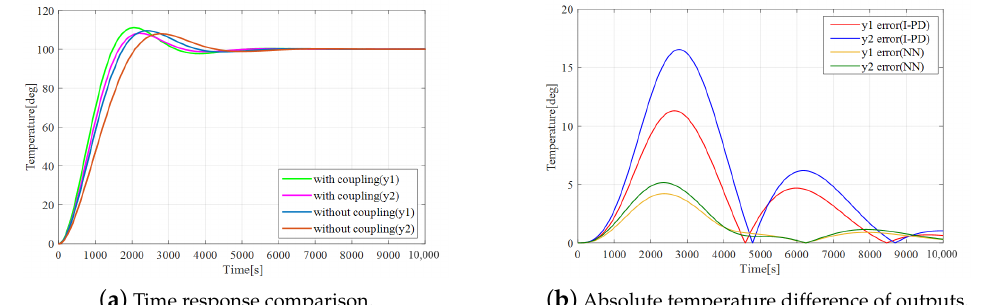
Figure 10. Analysis of coupling effects in the control system. ( a ) Compare time response results between the control system with coupling effects and without coupling effects. ( b ) Absolute temperature difference of outputs between the control system with coupling effects and without coupling